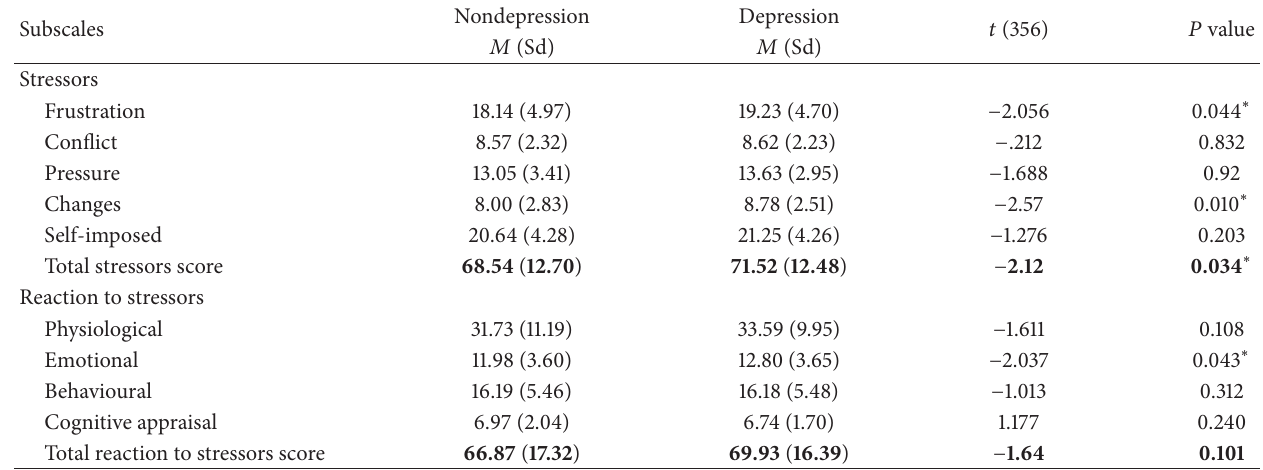
Table 6: Difference between depressed and nondepressed students stressors and reaction to stressors.